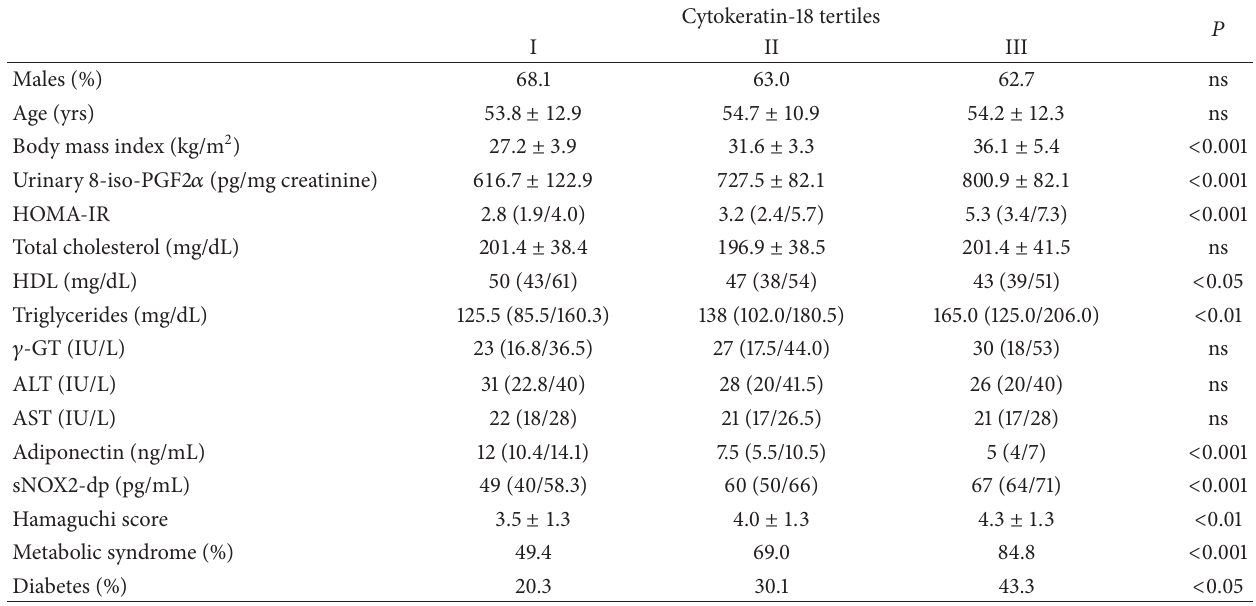
Table 2: Clinical and biochemical characteristics of 209 subjects with NAFLD divided by serum cytokeratin-18 tertiles.